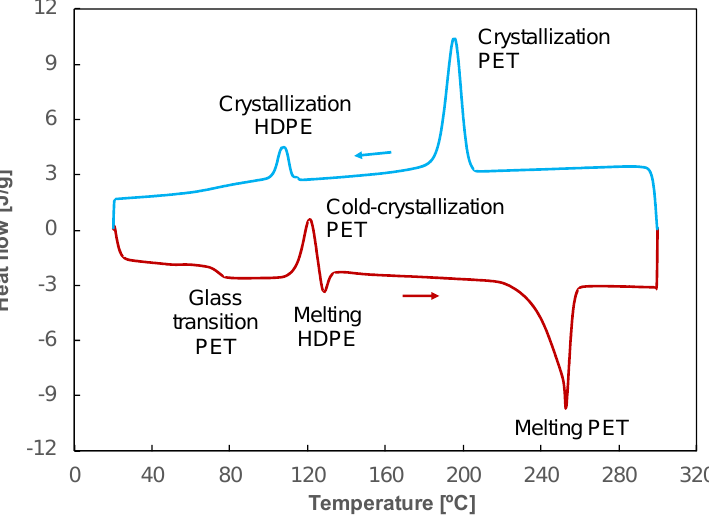
Figure 7. Heating (red curve, down) and cooling (blue curve, up) thermograms of a part printed with a filament of PET contaminated with 5 wt% HDPE.